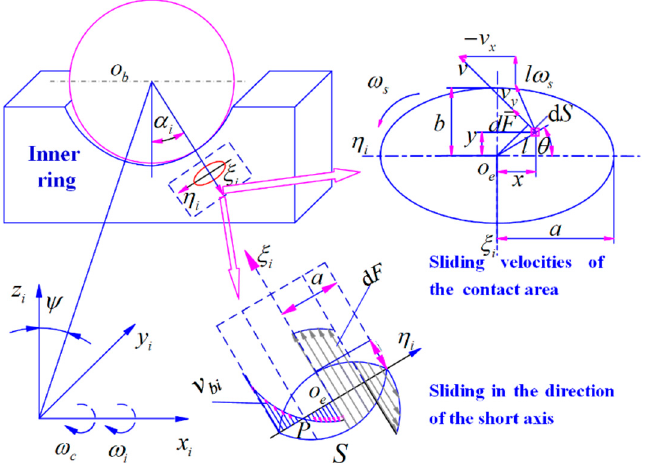
Figure 10. Sliding velocities of the area dS in the elliptical contact area.